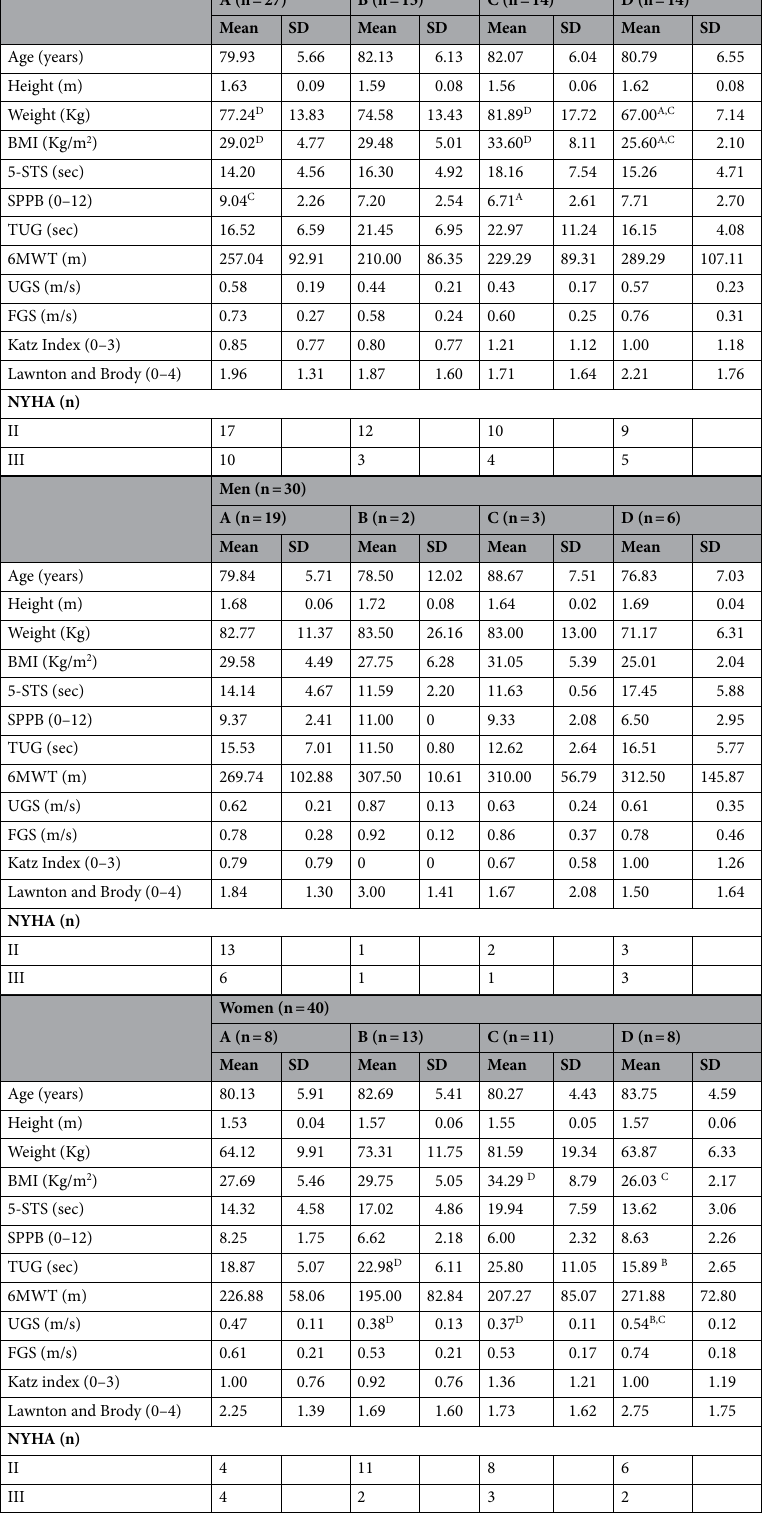
Table 4. Comparison of each variable among the four US types classified based on exploratory hierarchical cluster. (A) normal MT, FT, MEI and FEI; (B) increased FT, relatively decreased MT to FT, slightly high FEI and slightly low MEI; (C) very increased FT, normal MT, decreased MEI and slightly high FEI; (D) decreased FT and MT and very high MEI with normal FEI US Ultrasound, BMI Body Mass Index, 5-STS Five-Repetitions Sit-to Stand, SPPB Short Physical Performance Battery, TUG Timed Up and Go test, 6MWT 6 Minute Walking Test, UGS Usual Gait Speed, FGS Fast Gait Speed, NYHA New York Heart Association class, SD Standard Deviation. A,B,C,D p < 0.05; A*, B*, C*, D* p <